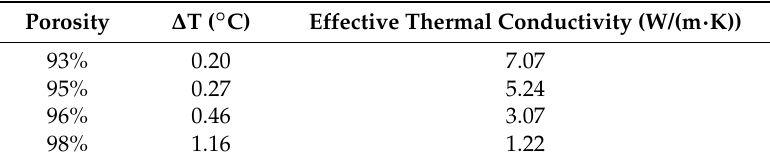
Table 3. Effective thermal conductivity in 3D B-P